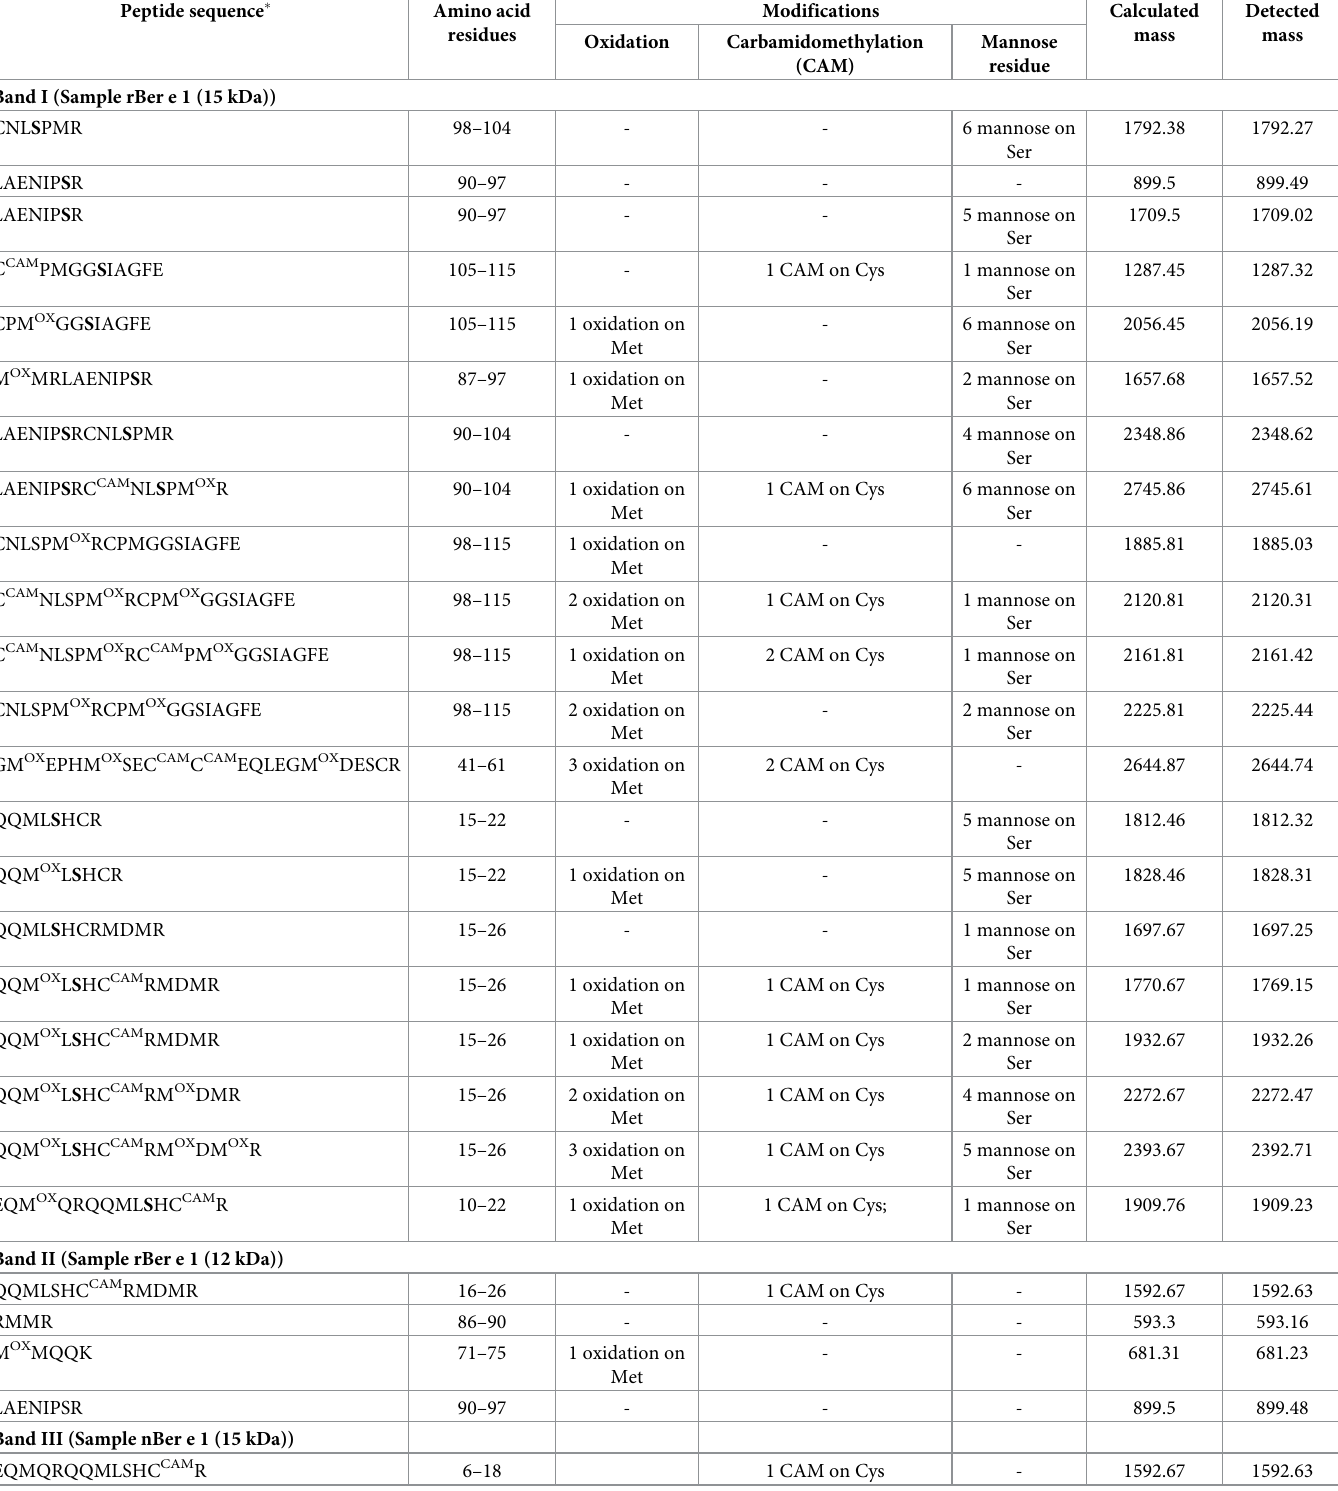
Table 1. Comparison and correlation of observed masses with calculated masses of tryptic peptides of rBer e 1 and nBer e 1. Peptide sequence